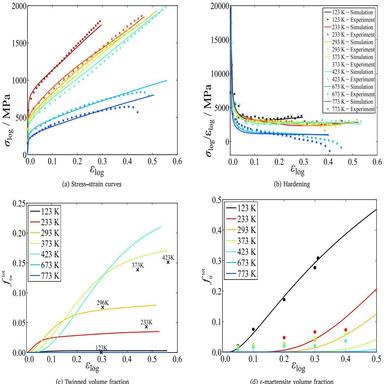
Comparison between experimental (indicated by crosses and dots) and simulated (indicated by lines) results using the TRIP/TWIP model for Fe-22Mn-0.6C steel. Figure adopted from with permission from Elsevier.